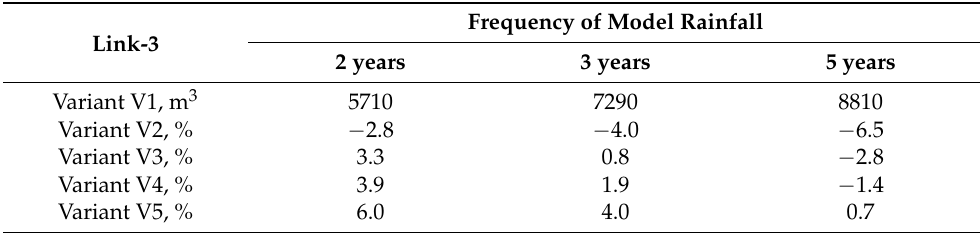
Table 5. Reduction of runoff volume in relation to the base variant—Link 3 calculation